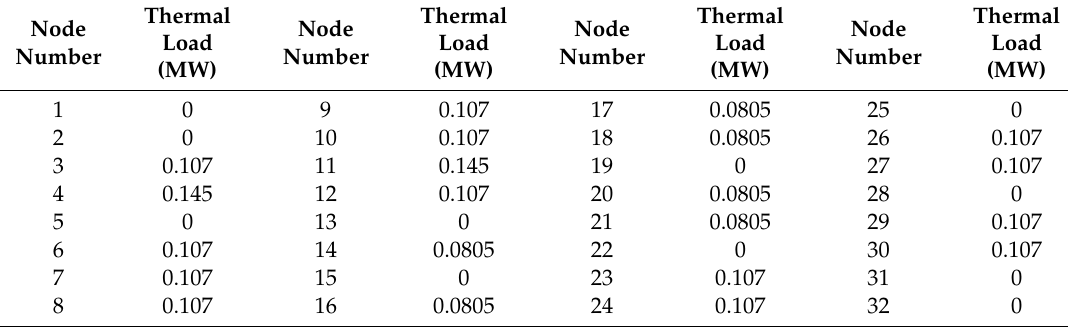
Table A1. Data of thermal load at each